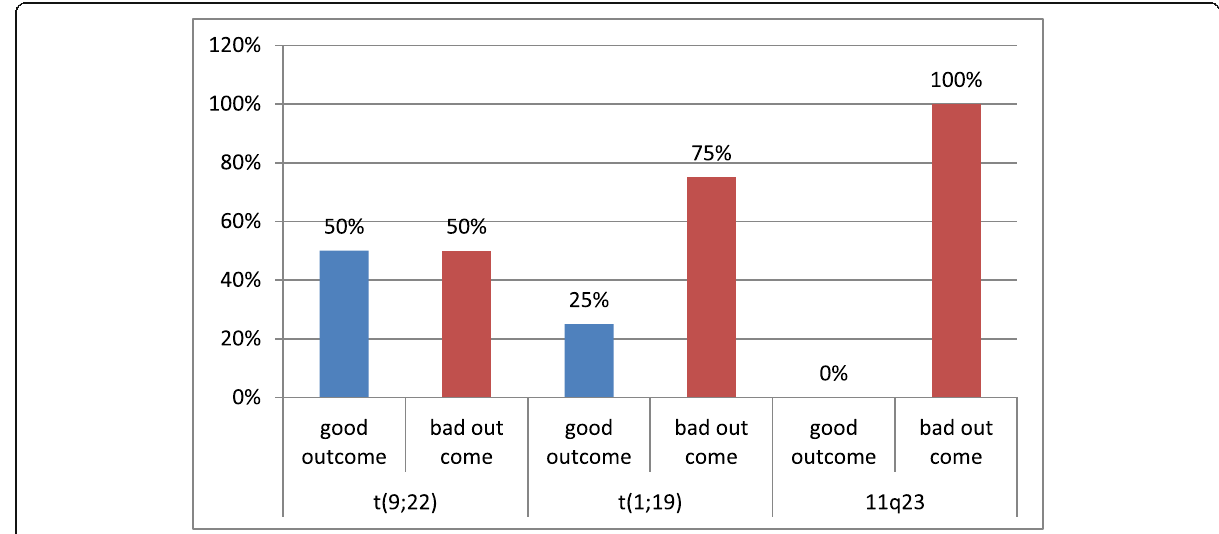
Fig. 6 The outcome at day 15 in each cytogenetic abnormality